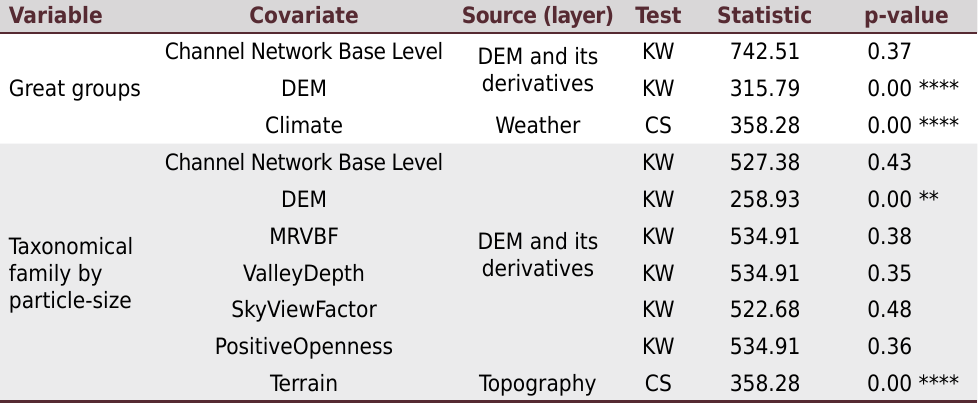
Table 6. Kruskall Wallis (KW) test compares means of optimal continuous covariates among groups of target categorical variables. Chi-square (CS) test when investigating relationships between categorical variables